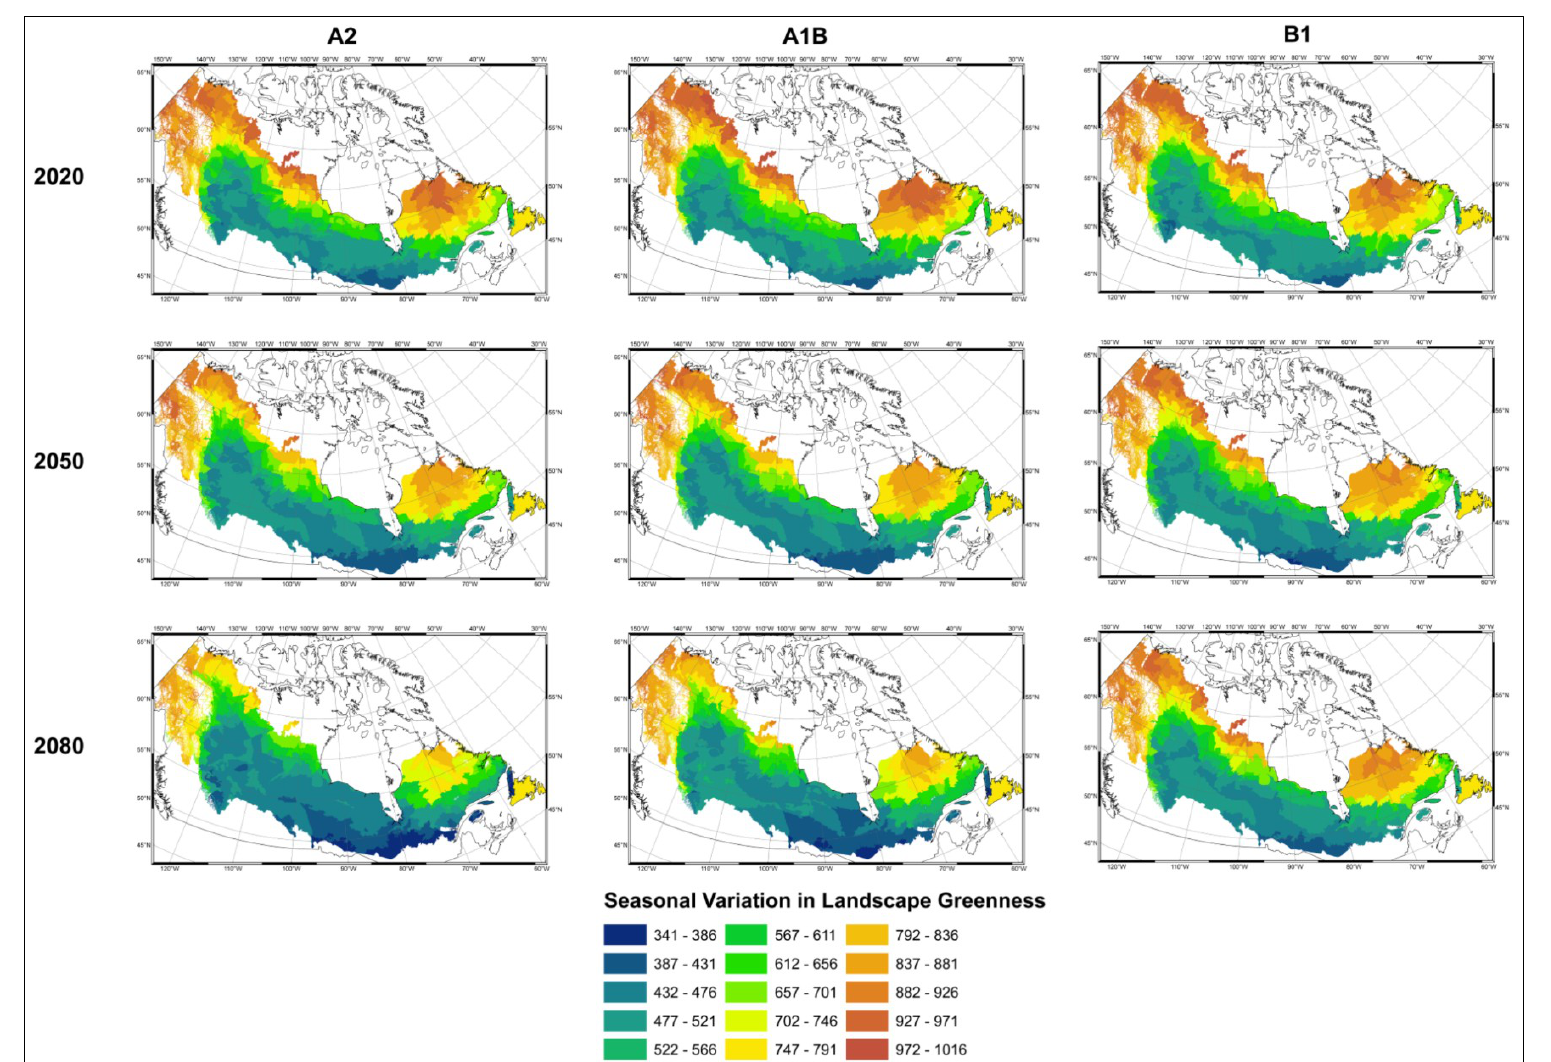
Figure 4. Predicted spatial distribution of seasonal variation in greenness for 2020, 2050, and 2080 based on three IPCC climate change scenarios: A2 (most change), A1B (business as usual), and B1 (least